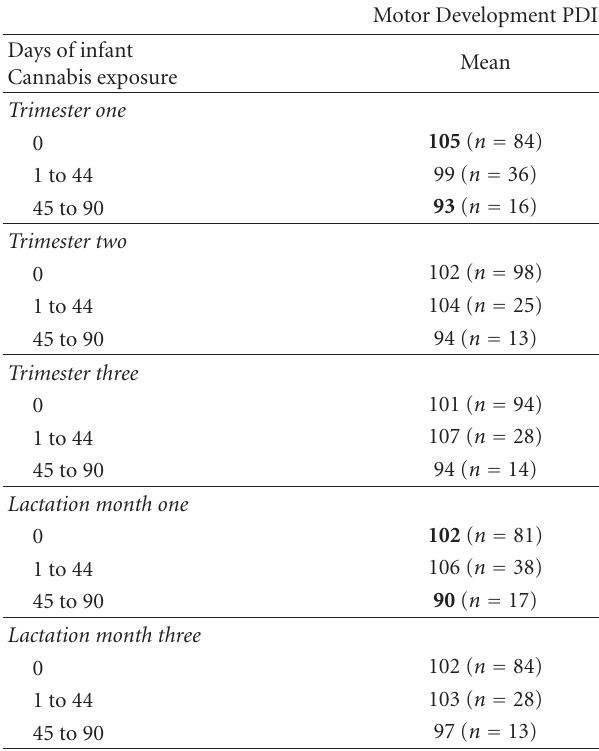
Table 1: Mean motor development scores ∗ corresponding with cannabis exposure during gestation and lactation